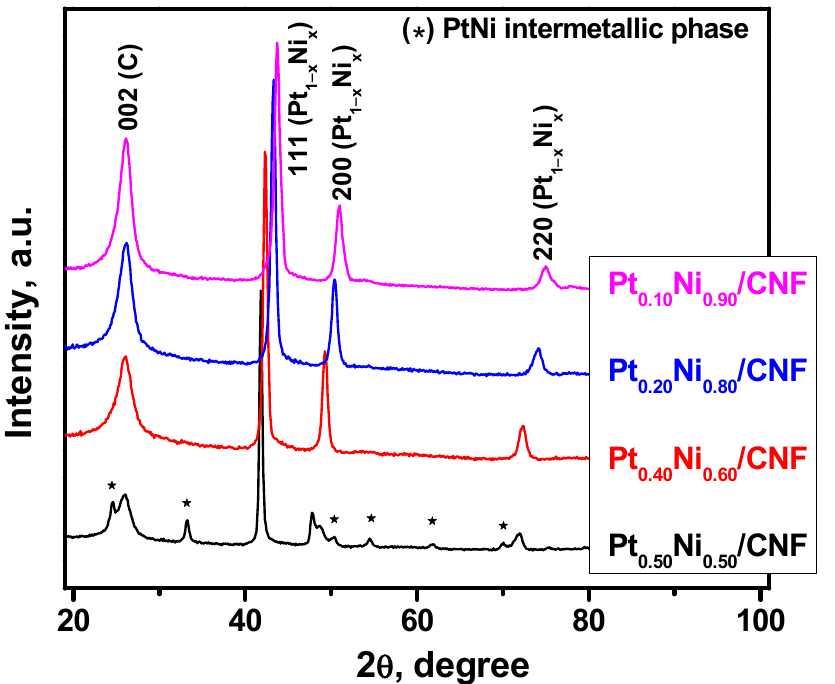
Figure 5. XRD patterns of Pt 1 − x Ni x /CNF composites synthesized via ethylene decomposition over the respective alloys. Asterisks (*) show the superstructural reflections of the PtNi intermetallic phase.